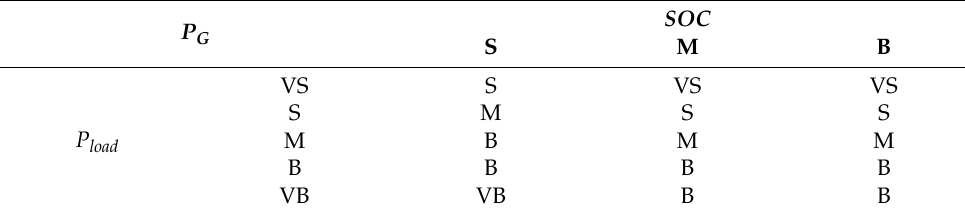
Table 2. Fuzzy logic rule